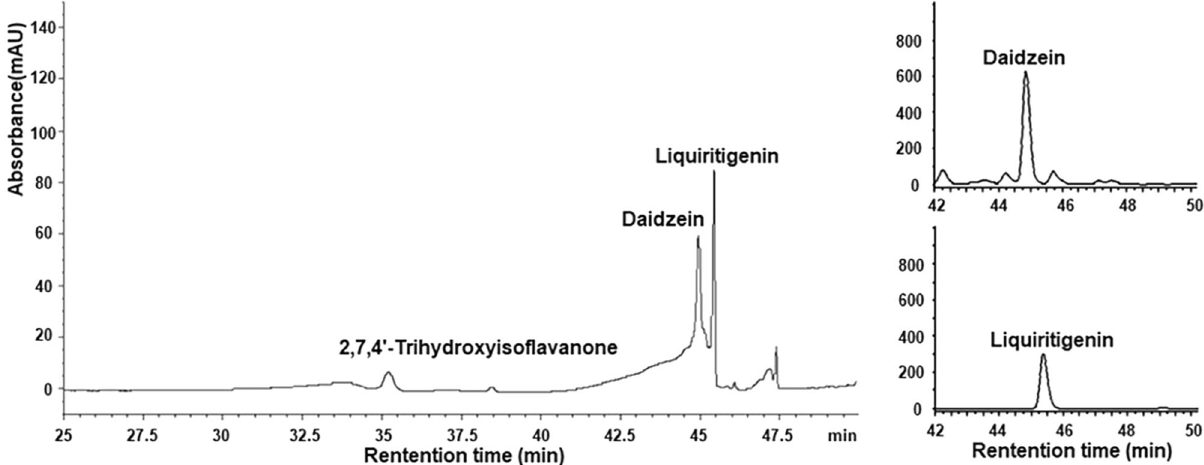
Fig. 7 HPLC pro fi les of 2-HIS reaction products. 2-HIS enzyme was from dissolved crystals, and substrate liquiritigenin was converted to 2,7,4 ’ - trihydroxyiso fl avanone which was subsequently dehydrated to daidzein. The right panels are the HPLC pro fi les of authentic standards liquiritigenin and